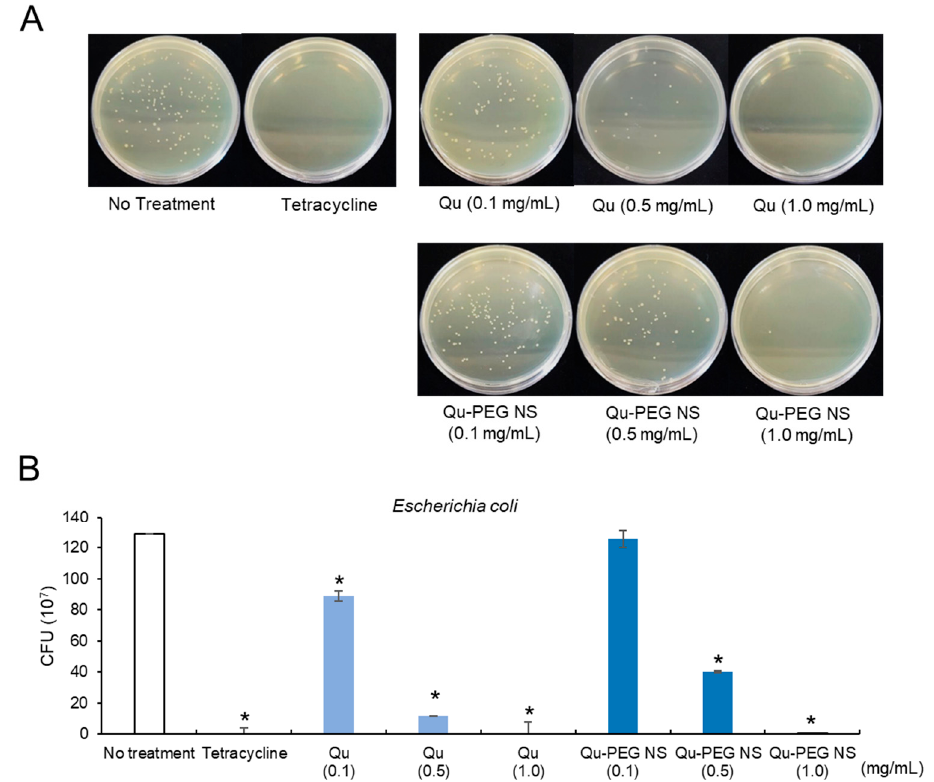
Figure 13. Antibacterial activity of Qu and Qu-PEG NS against E. coli ( A ) Colony forming on growth medium and ( B ) Number of colonies forming units, * p < 0.05 significant difference compared to control.